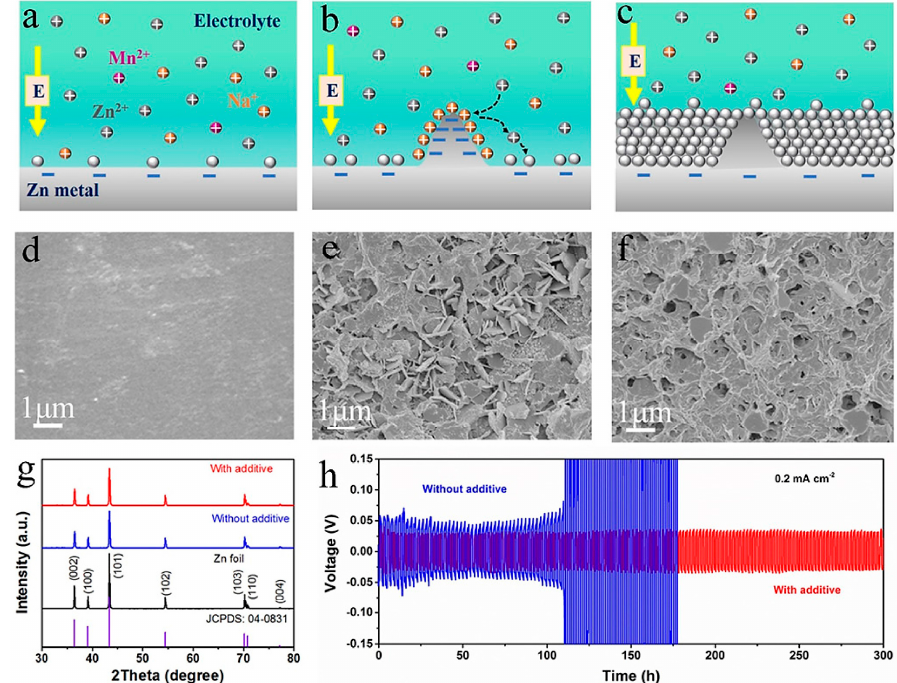
Figure 6. The influence of Na 2 SO 4 additive on the metallic Zn anode. ( a – c ) Illustration of the Zn deposition process according to the electrostatic protection mechanism. ( d ) the SEM image of the commercial Zn surface before measurement. ( e ) the electrodeposited morphology of Zn surface after five CV tests in ZnSO 4 electrolytes without Na 2 SO 4 additive. ( f ) the electrodeposited morphology of Zn surface after five CV tests in ZnSO 4 electrolytes with 0.5 M Na 2 SO 4 additive. ( g ) The XRD patterns of fresh Zn foil and the electrodeposited Zn electrodes with/without Na 2 SO 4 additive. ( h ) Polarization curves of Zn//Zn symmetric batteries with/without Na 2 SO 4 additive at a constant current density of 0.2 mA cm − 2 . Reproduced with permissions from the Ref. [67]. Copyright © 2021 Elsevier Ltd.